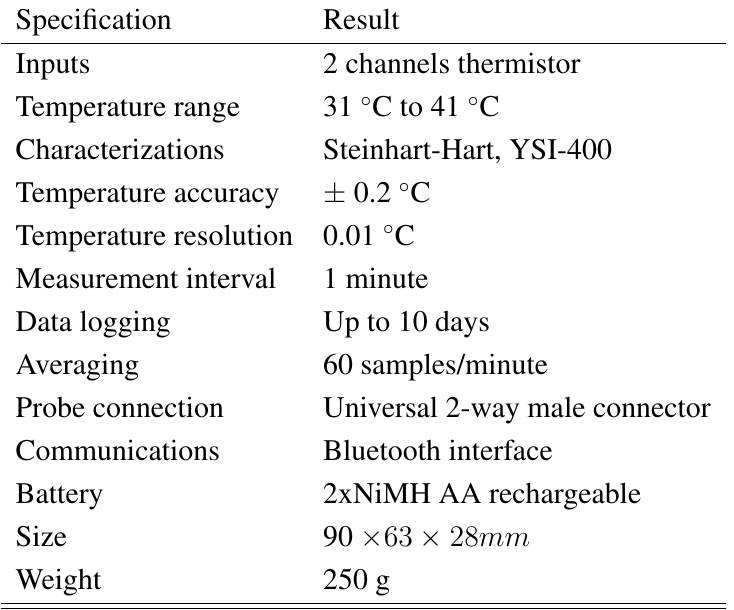
Table 1. Results of the Characterization Study and Final TherCom